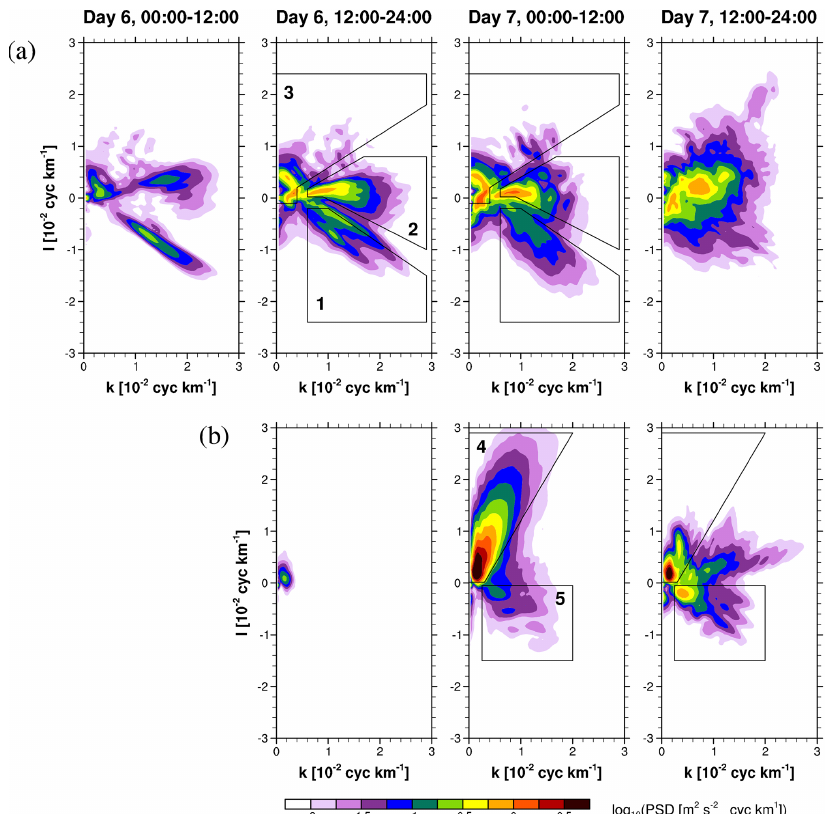
Figure 4. Twelve-hour averaged power spectra of w (cid:48) at z = 8km as a function of zonal and meridional wavenumbers calculated in (a) 48– 73 ◦ N, 20–60 ◦ E and (b) 21–46 ◦ N, 20–60 ◦ E from day 6 to day 8 (from left to right). In (b) , the plot for 00:00–12:00UTC on day 6 is